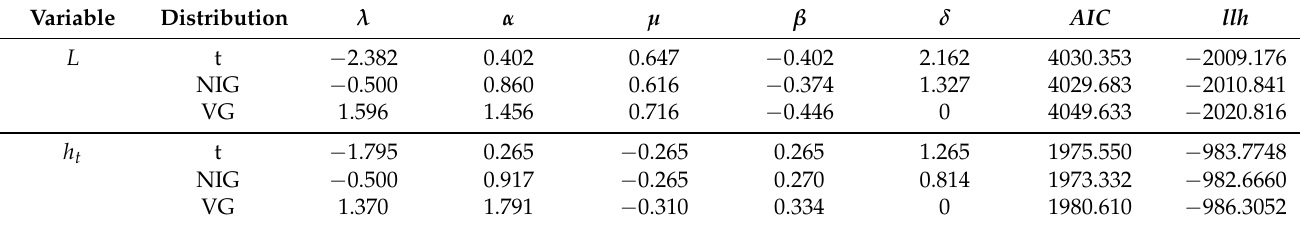
Table A2. Estimated parameter values of different distributions belonging to the Generalized Hyperbolic class and corresponding values of the Akaike information criterion AIC and the log likelihood value llh .